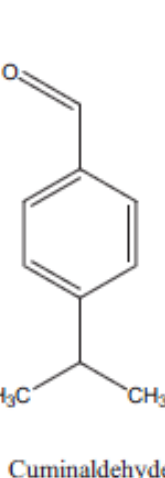
Fig. 1. Chemical structures of cuminaldehyde